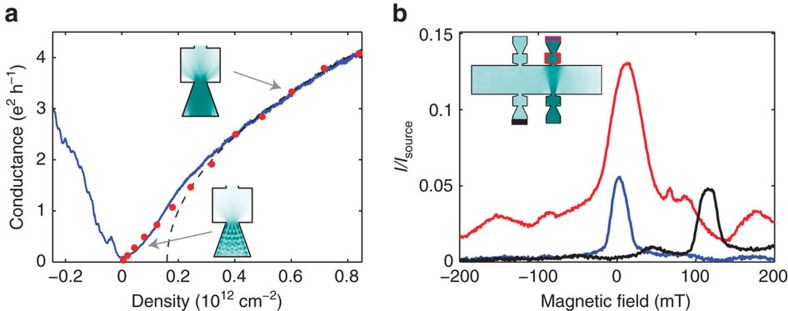
Conductance of single and paired collimators.(a) Conductance of collimator measured in a three terminal configuration: S4 is current-biased, F4 is grounded and all remaining terminals are measured with a single current amplifier. The measured conductance (blue) scales as  (black dotted line), qualitatively agreeing with ballistic conduction of bulk graphene. Numerical solutions to the 2D Dirac equation (red dots) account well for low-density effects associated with diffraction. (b) Conductance measurements through angularly sensitive collectors. Current is collected at F3+S3 (red), S3 (blue) and S1 (black) with all remaining contacts grounded. F3+S3 has a broad background due to diffuse edge scattering and imperfect ohmic contacts. S3 has a FWHM of 8.5° due to double collimation and has minimal diffuse background. The peak height of S3 indicates nearly perfect ballistic transmission.